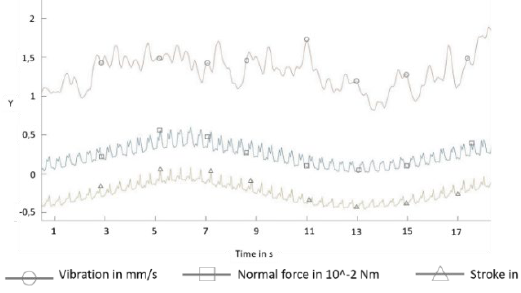
Fig. 2. First sensor data from the polishing head monitored by the PLC (Programmable Logic